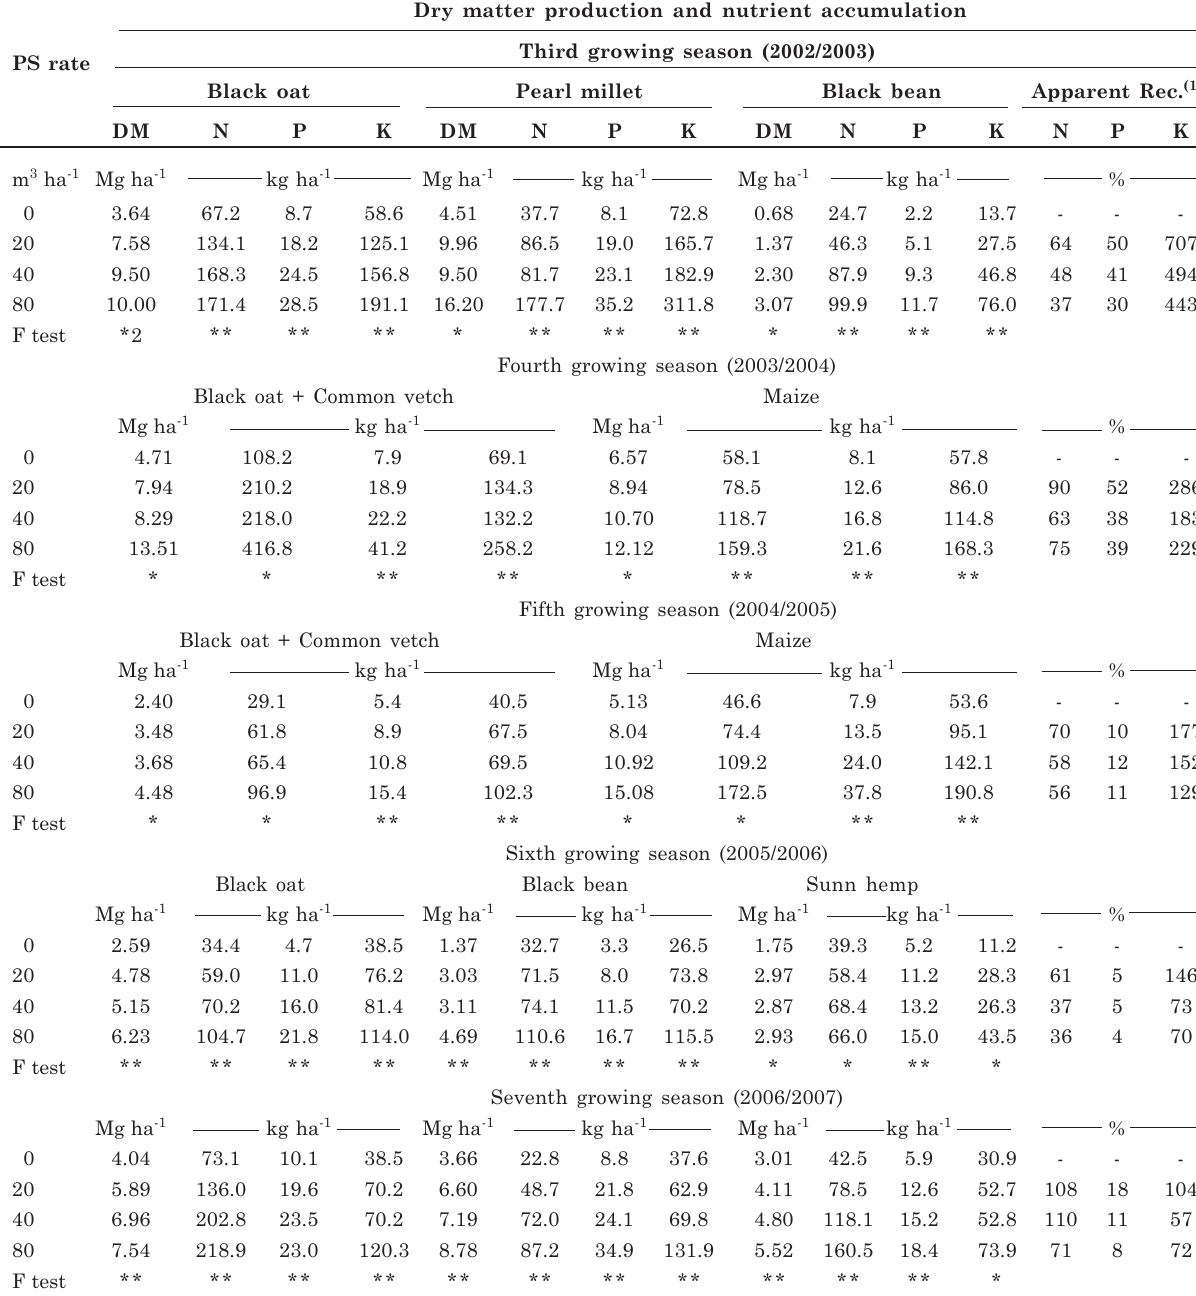
Table 3. Dry matter production and accumulated quantity of N, P and K in the plant tissues of crops